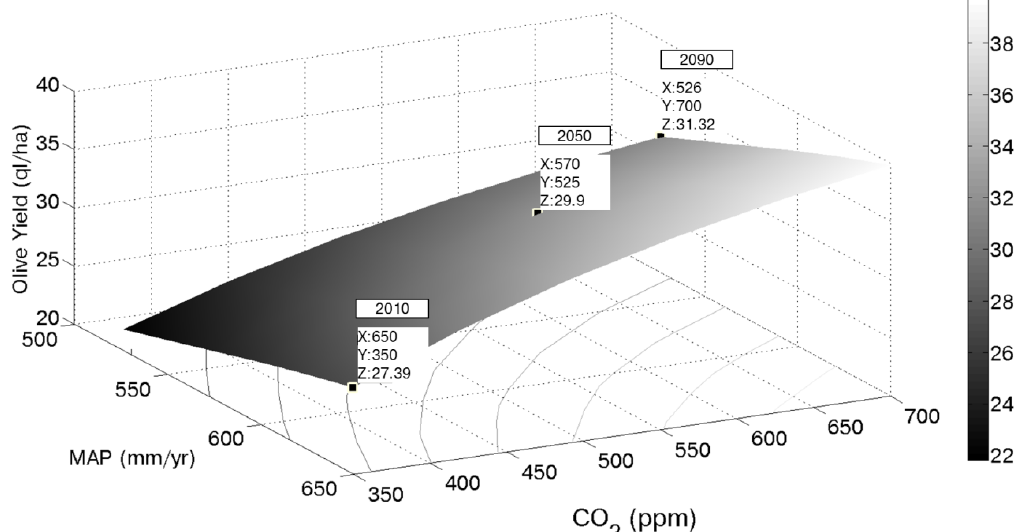
Figure 7. Mean annual olive yields as a function of CO precipitation (MAP). Results in the three considered future scenarios are highlighted. Iso-productivity lines are projected using the gray scale on the